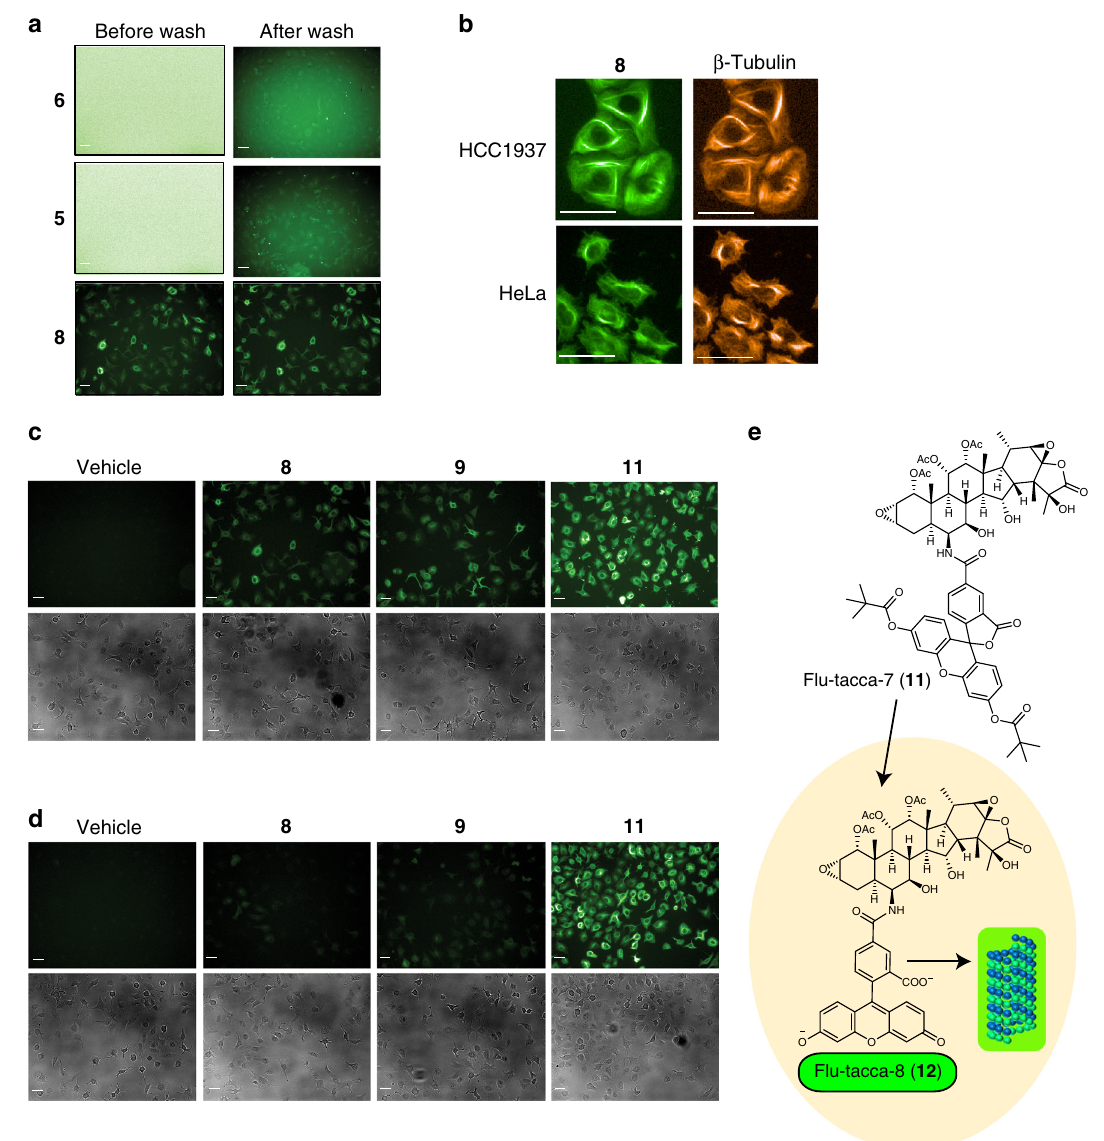
Fig. 4 Optimization of taccalonolide- fl uorescein probes. a Visualization of unprotected ( 6 ), acetyl-protected ( 5 ), and pivaloyl-protected ( 8 ) probes in live SK-OV-3 cells 5 h after the addition of 5 µ M probe either before (left) or after (right) medium containing probe was removed and replaced by fresh medium. b Co-localization of 8 (green) with β -tubulin immuno fl uorescence (orange) in fi xed HCC1937 and HeLa cells after 10 µ M probe addition for 6 h. c , d Pivaloyl-protected taccalonolide- fl uorescein probes with decreasing linker sizes (left to right) were added to SK-OV-3 human ovarian cancer cells at a concentration of 5 µ M c or 0.5 µ M d and incubated for 5 h prior to imaging. The same image acquisition and processing conditions were used for each image to directly compare relative fl uorescence properties (top rows) along with bright fi eld images of the fi eld (bottom row). e A no-wash fl uorogenic labeling system for cellular tubulin employing the dipivaloyl-protected taccalonolide probe Flu-tacca-7 ( 11 ), which is cleaved to generate Flu-tacca-8 upon cellular entry where it can bind cellular microtubles. Scale bars = 50 µ m for all images. Source data are provided as a Source Data fi